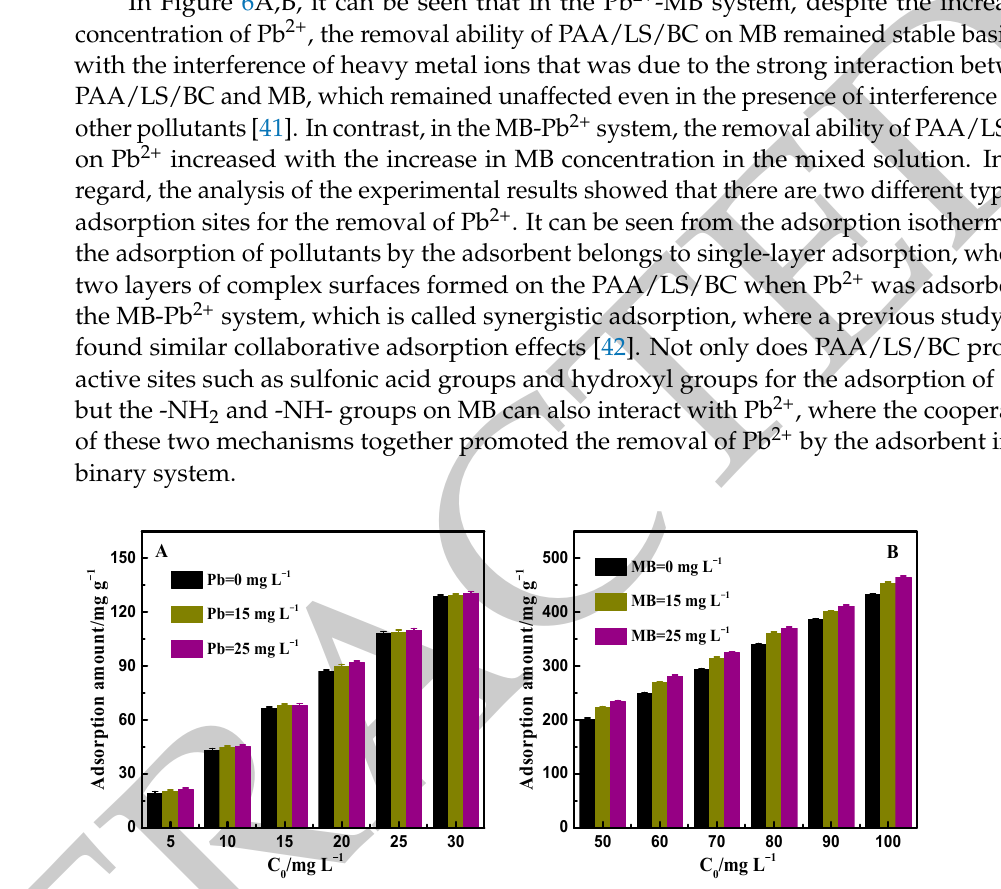
Figure 6. Adsorption amount of PAA/LS/BC to MB in Pb 2+ -MB system ( A ); adsorption amount of PAA/LS/BC to Pb 2+ in MB-Pb 2+ system ( B ).